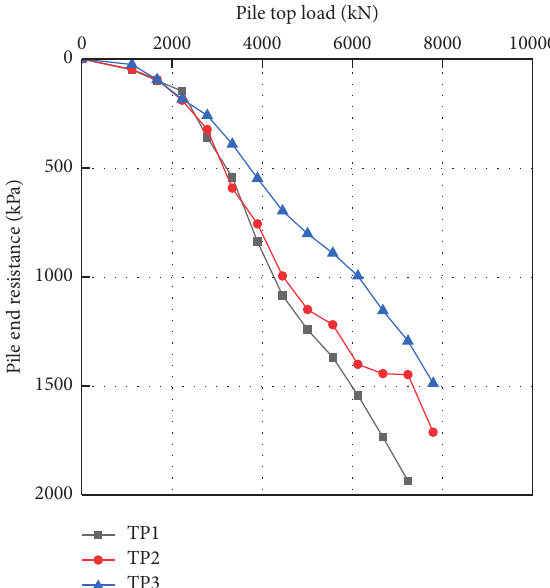
Figure 7: Relationship between pile top load and pile end